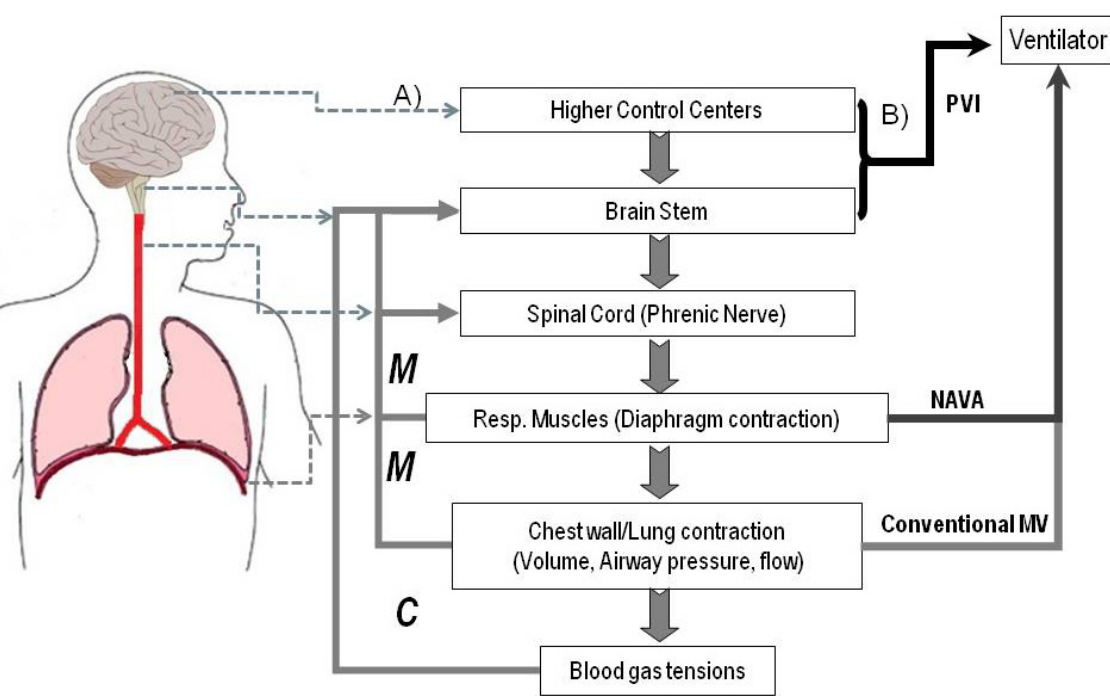
Figure 2. Basic schema of afferent and efferent processes in the control of breathing ( left ) and control signals that can be used to interface patients with ventilators ( right